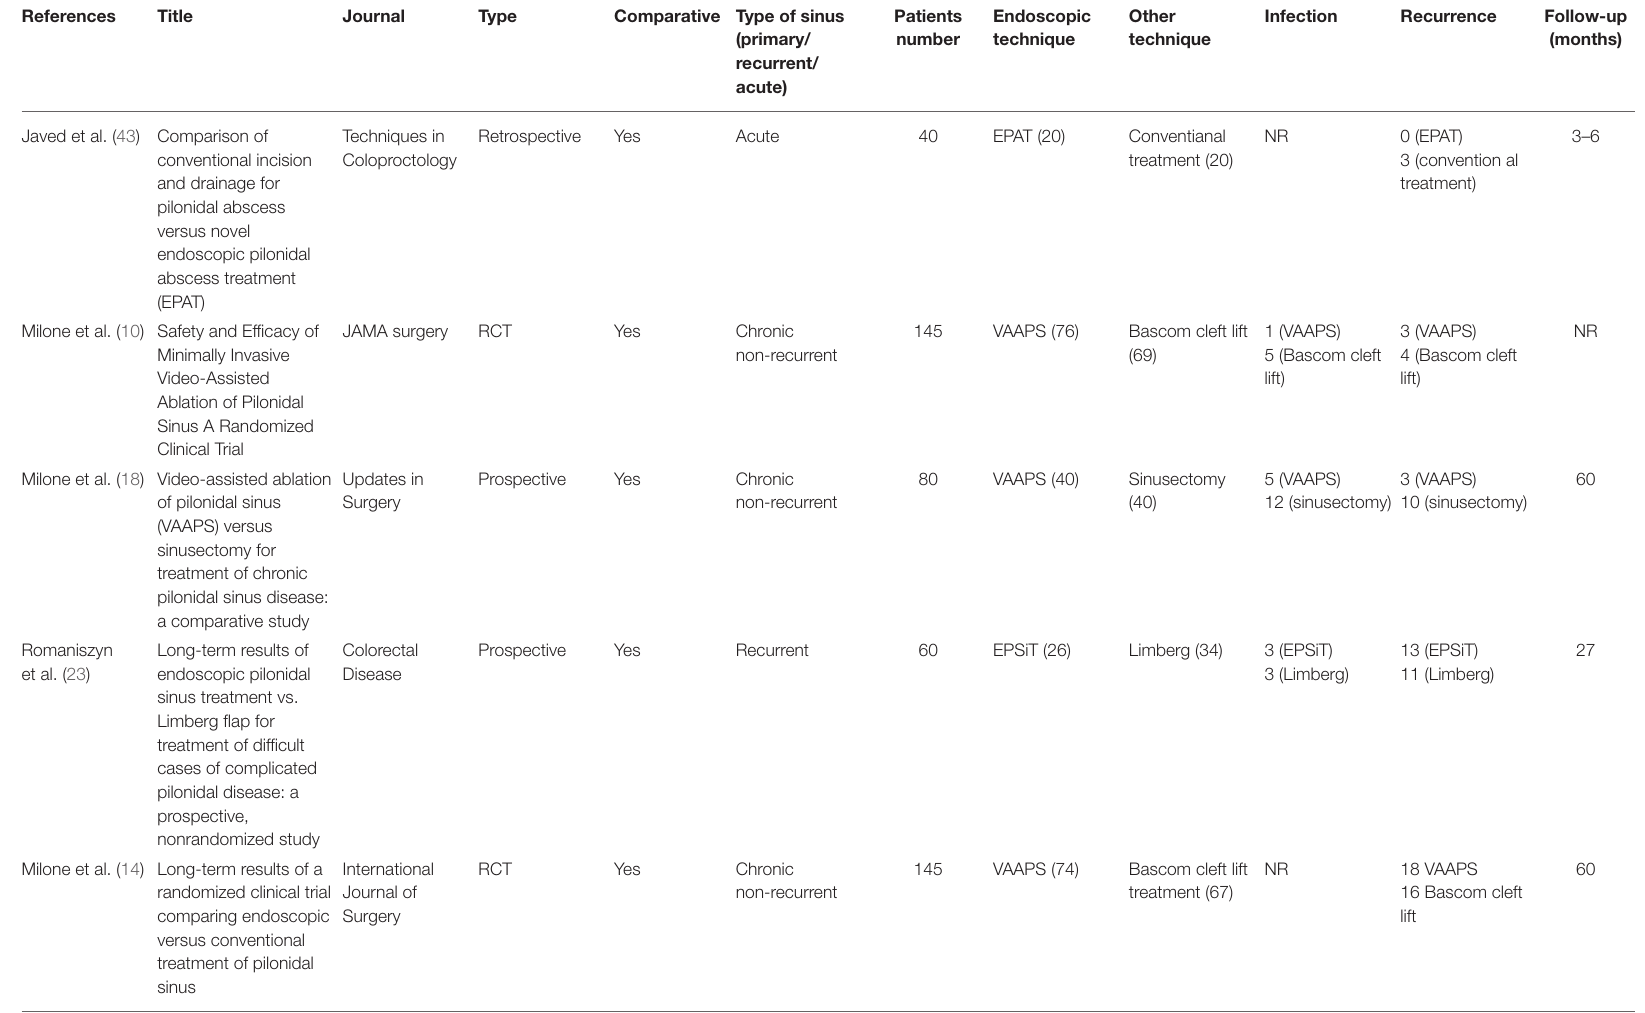
TABLE 2 | Comparative studies on the endoscopic approach in the adult